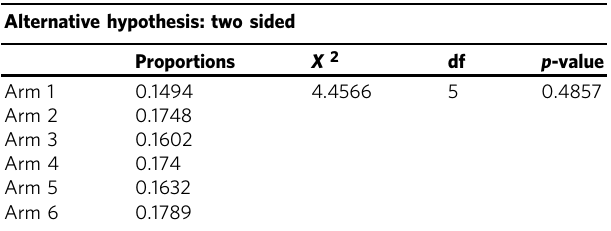
Table 1 Test for equality of proportions in the